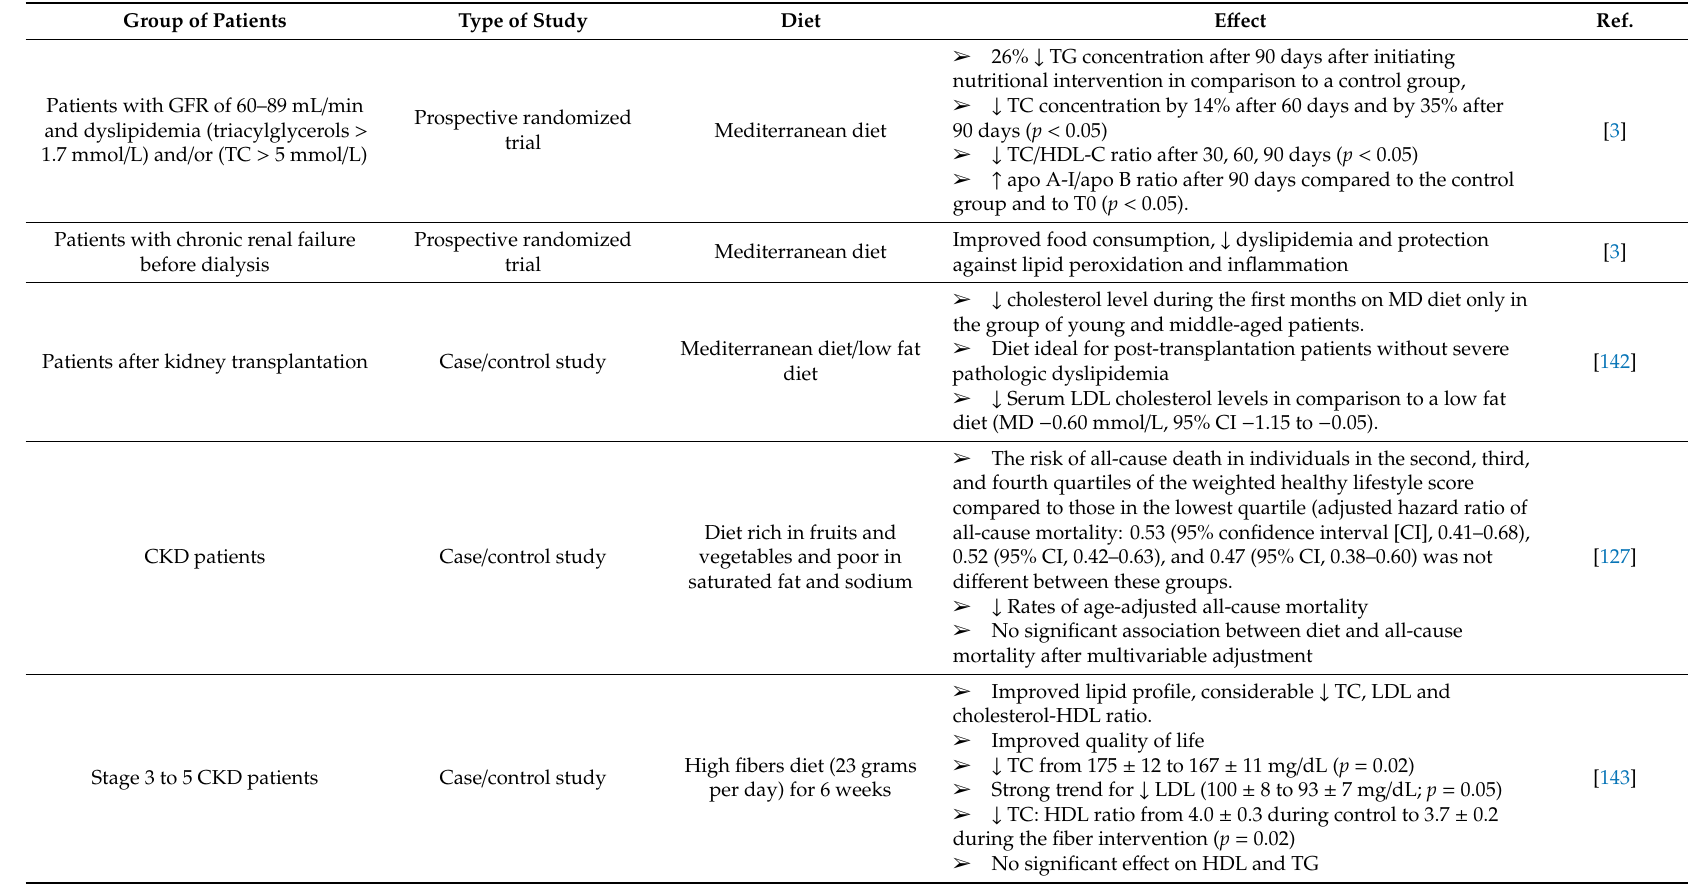
Table 3. Summary of diet e ff ects in CKD